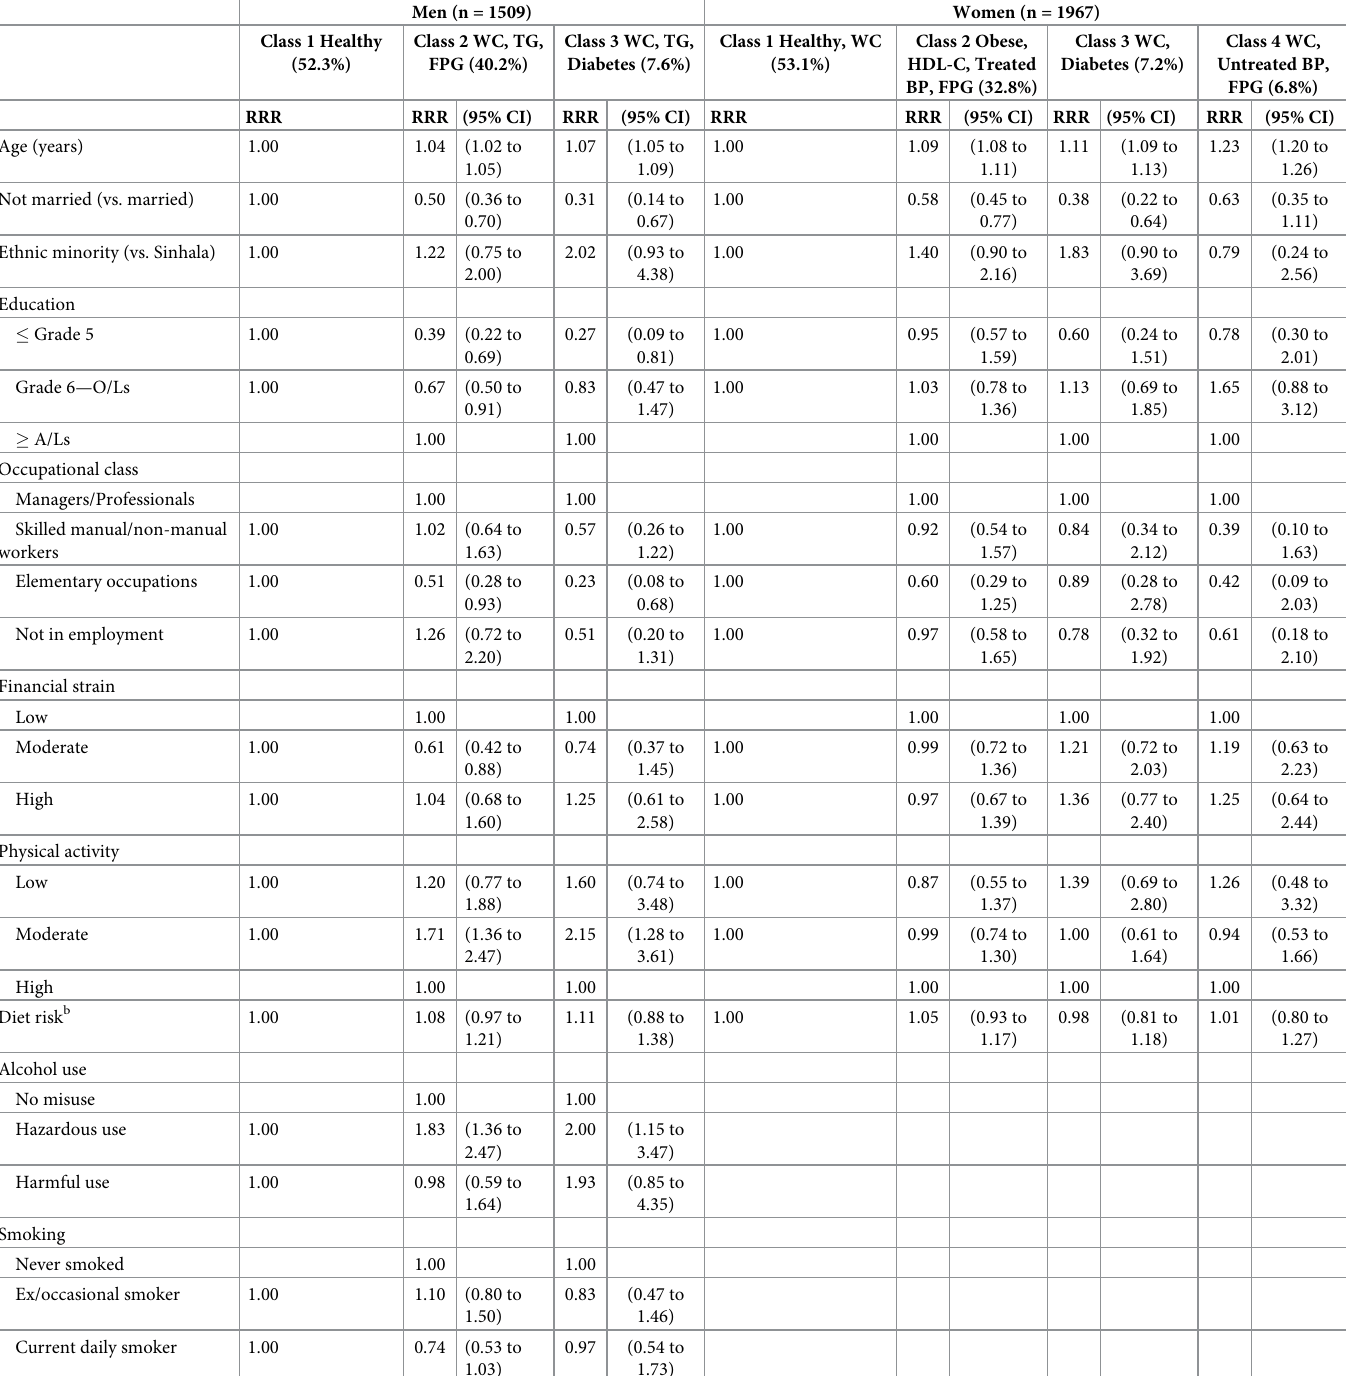
Table 2. Adjusted a associations between latent cardiometabolic classes and socio-demographic characteristics and health behaviorus.